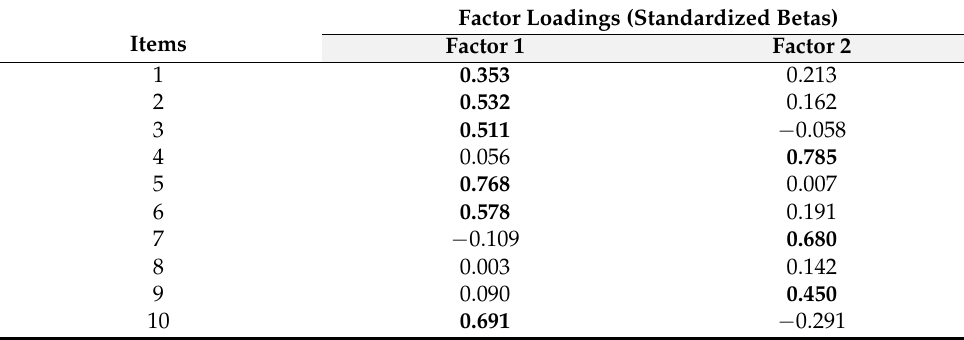
Table 4. Exploratory factor analysis of the self-care maintenance